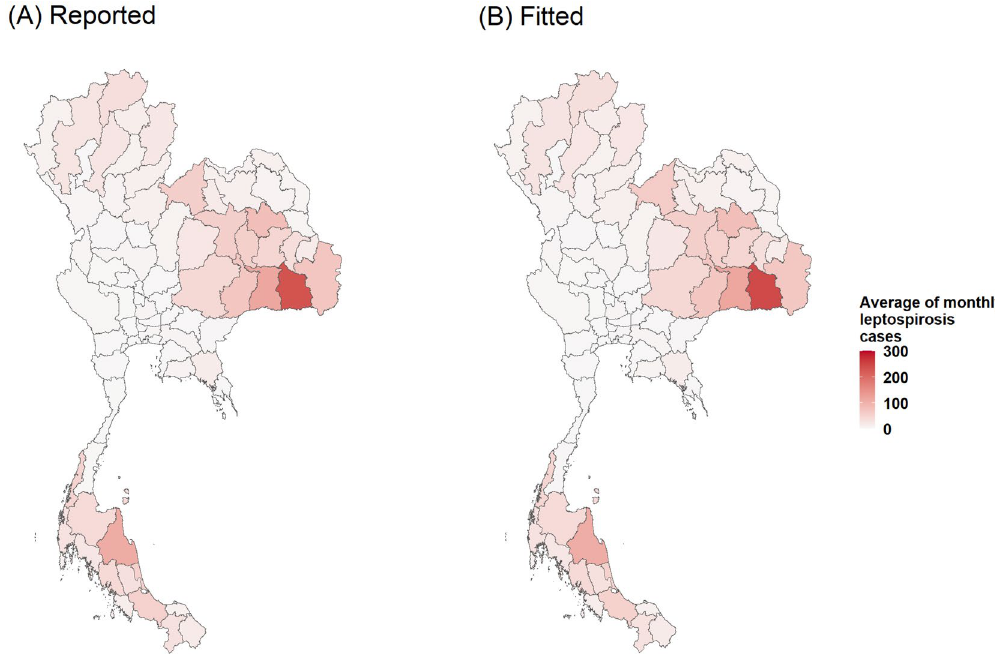
Figure 6. Plots of comparison between average monthly reported leptospirosis cases ( A ) and average monthly fitted leptospirosis cases estimated by the final GLMM for temperature range parameter ( B ). Maps created